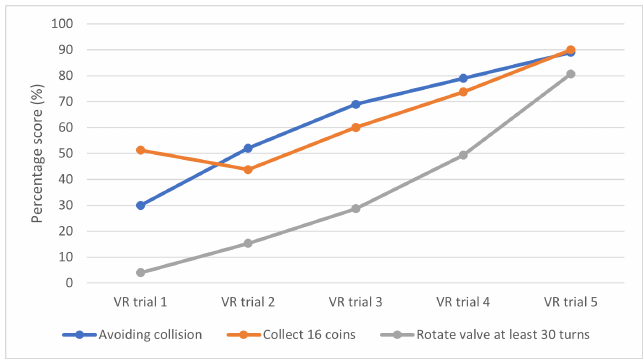
Figure 11. Percentage scores achieved by participants during training in Module 3 and 4 for five